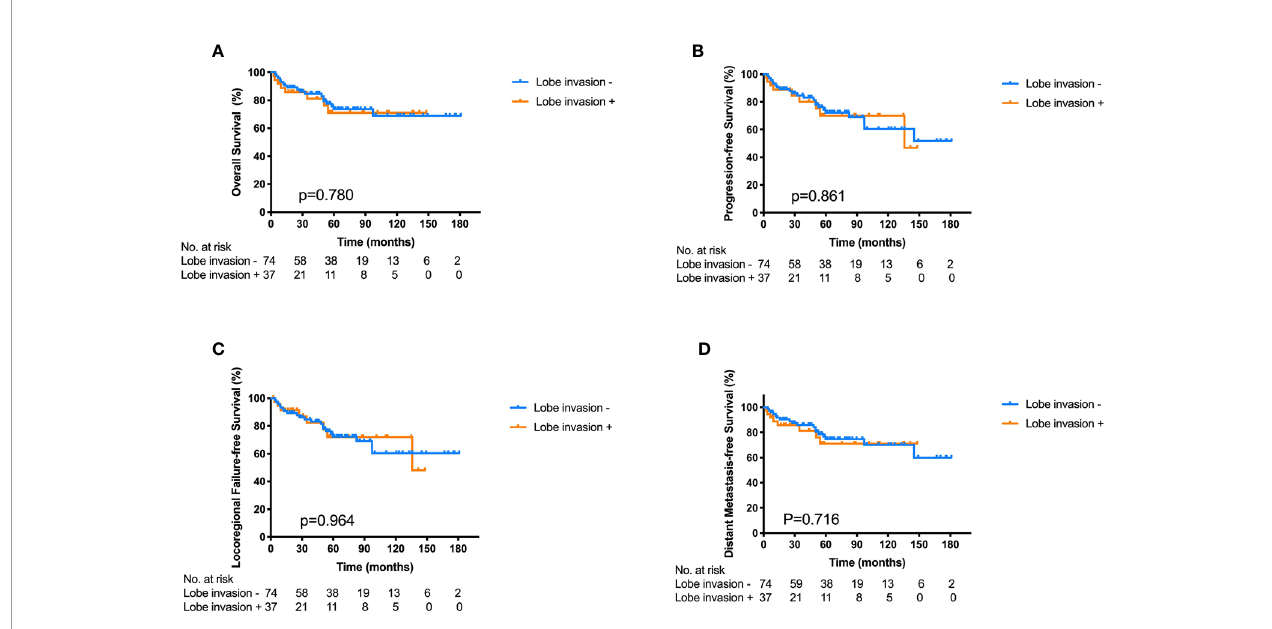
FIGURE 2 | Kaplan – Meier survival curves for overall survival (A) , progression-free survival (B) , locoregional failure-free survival (C) and distant metastasis-free survival (D) of the ONB patients with frontal lobe invasion (FLI) (n = 37) and those without FLI (n = 74), p-values calculated by log-rank